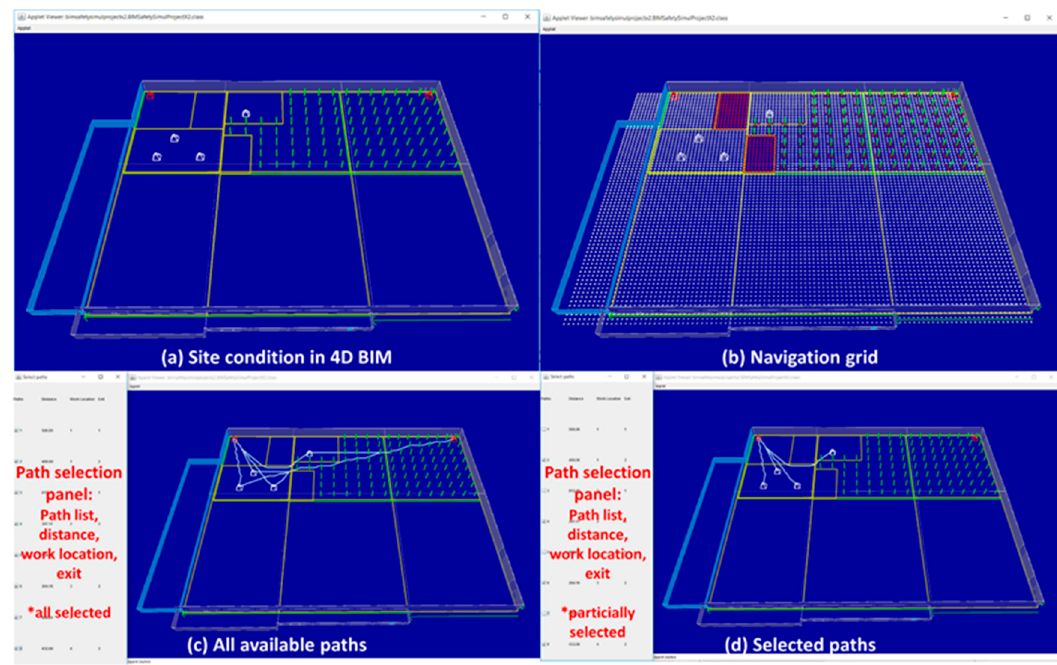
Figure 10. Scenario 1 ( a ) site condition, ( b ) navigation grid, ( c ) all available paths, and ( d ) selected paths.